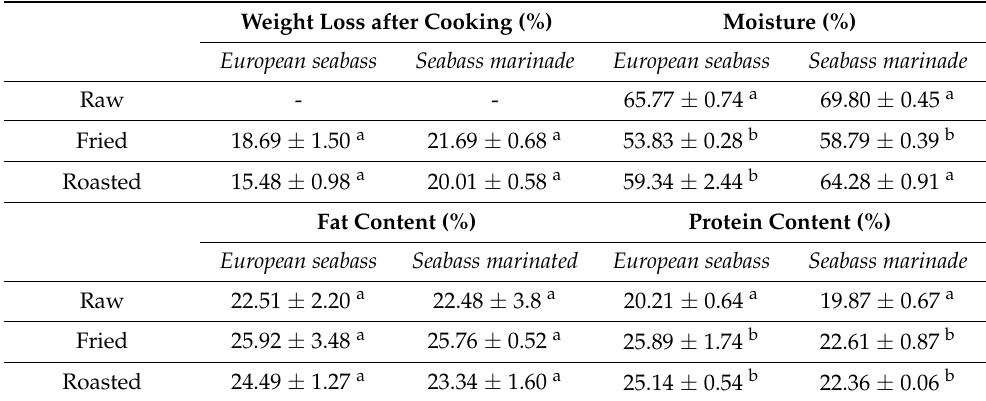
Table 2. Weight loss after cooking and nutritional composition of raw and cooked seabass, with or without green tea